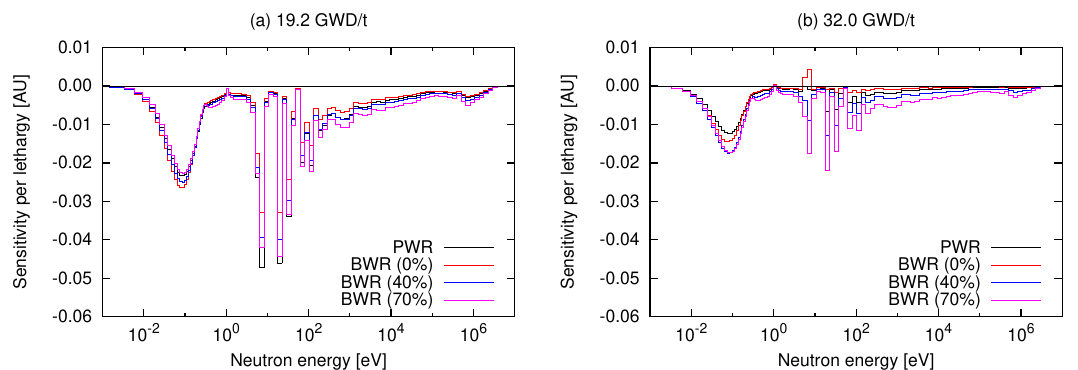
Figure 3: Sensitivity of k to (n, γ ) cross section of uranium-238 in the BWR assembly ∞